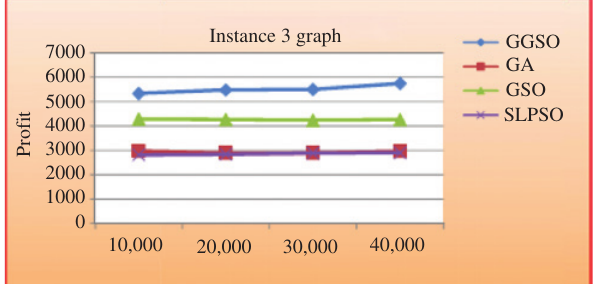
Figure 5: Performance of Profit Plot Proposed Against Existing Algorithm for Instance